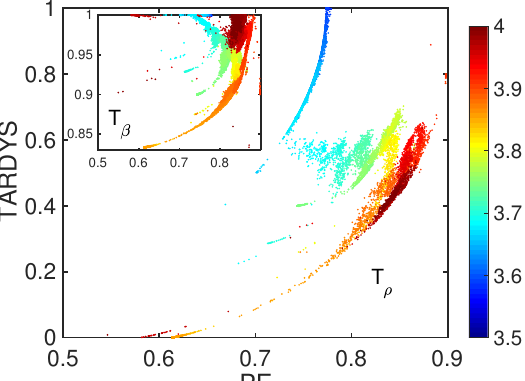
Figure 6. Reversibility T ρ as a function of Permutation Entropy (PE). Inset shows T β versus PE. Notice the similarity in shape but the difference in scale between both. Color code indicates the value of the control parameter 3.5 ≤ r ≤